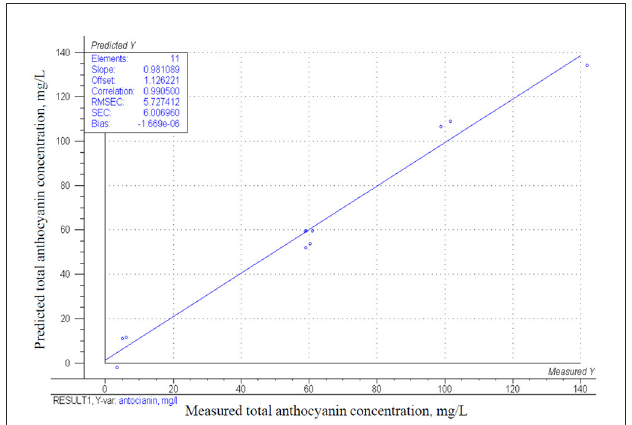
FIGURE5 Correlation of the obtained model and the measured results for the change in total anthocyanin concentration mg/L.